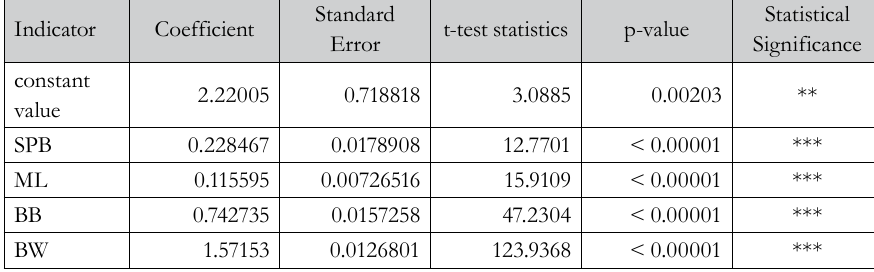
Tab. 2 – Summary of the second regression model. Source: own